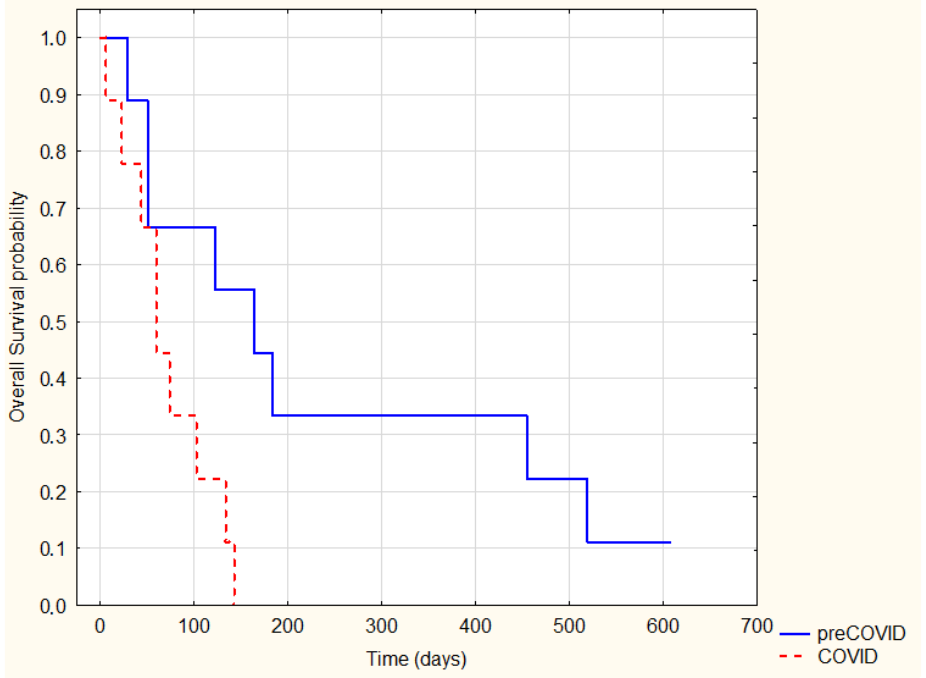
Figure 6. Kaplan–Meier Survival Analysis—NOS cancer pre-COVID-19 vs. COVID-19, log-rank p = 0.04.